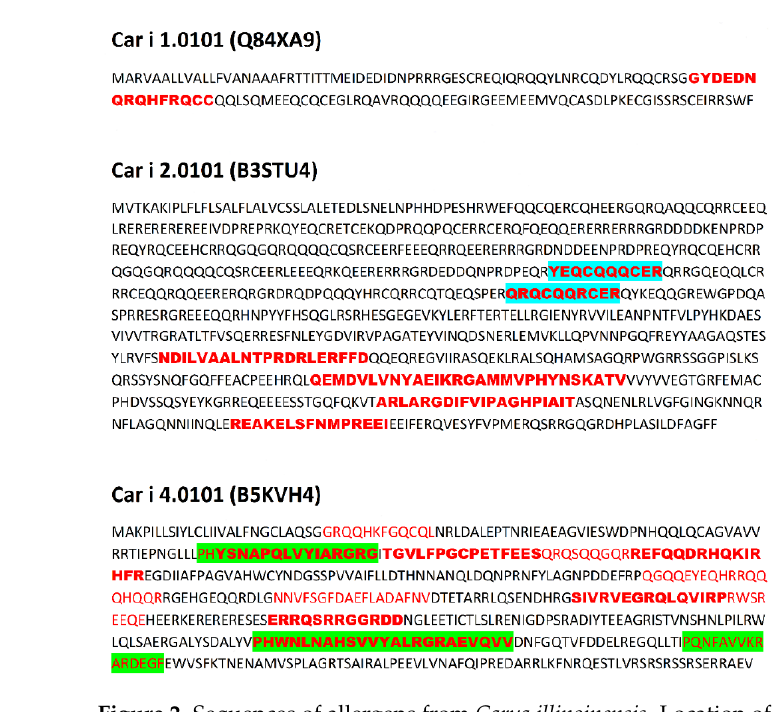
Figure 2. Sequences of allergens from Carya illinoinensis . Location of epitopes is indicated using red font. Green background indicates epitopes with highest ∑ A (range 1.6000–2.1000), blue background indicates epitopes with lowest ∑ A (range 0.1000–0.5999). Bold font indicates epitopes and their fragments occurring both in Carya illinoinensis and Juglans regia proteins.